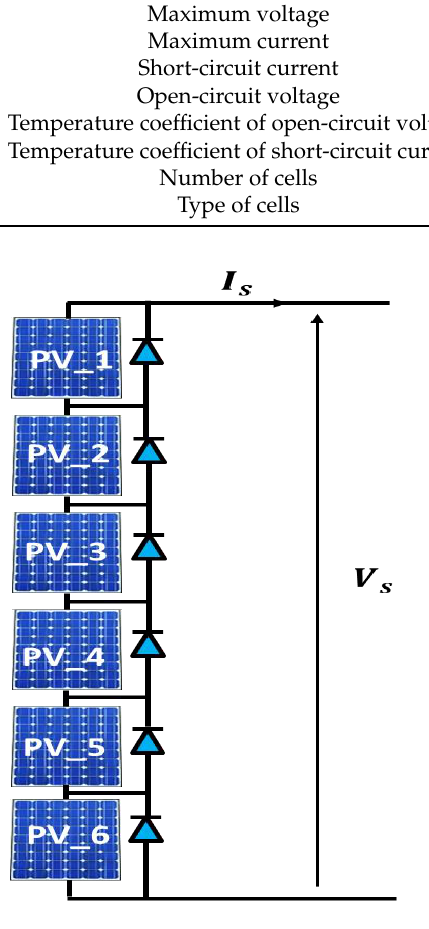
Figure 2. PV array configuration. Figure 2. PV array